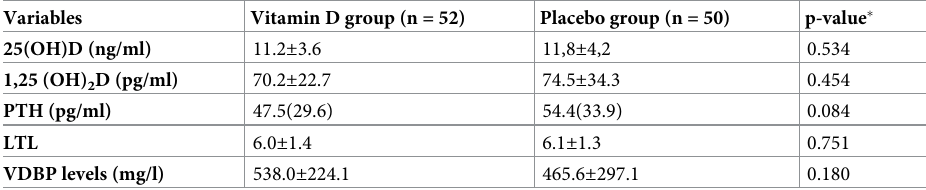
Table 4. Baseline levels of variables in vitamin D supplementation and placebo groups.